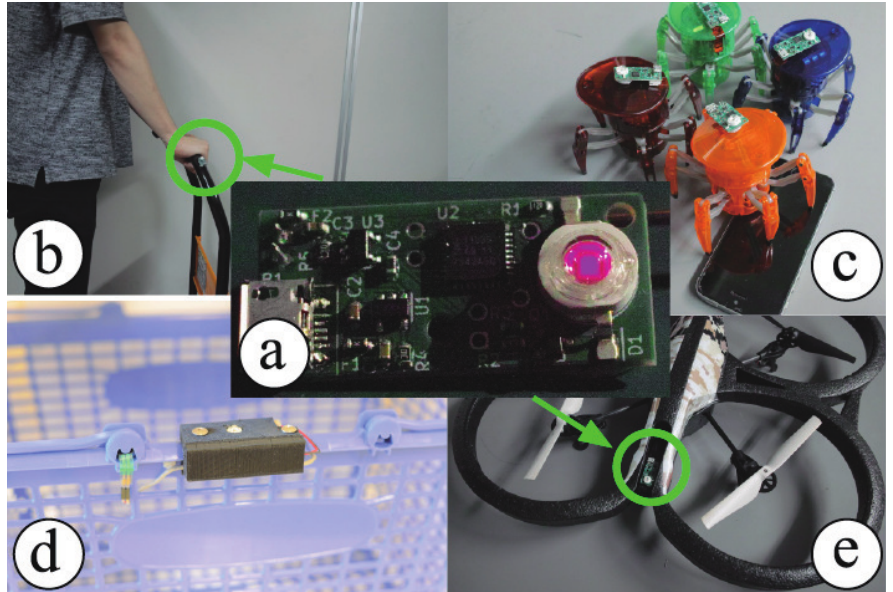
Figure 2. ( a ) Infrared (IR) beacon and applications; ( b ) hand cart; ( c ) small robots; ( d ) shopping basket; and ( e )